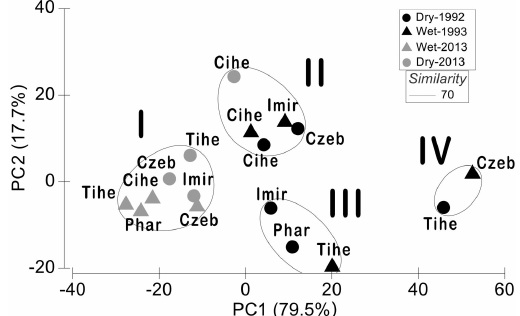
Figure 4. Results of the Principal Coordinates Analysis applied to the diet data based on the relative importance index of the fish species sampled in Capivara River. Species acronym presented in Table